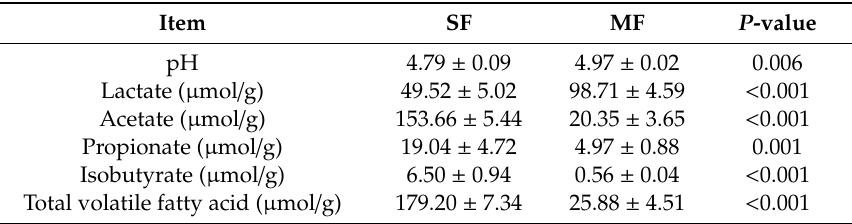
Table 1. The pH, lactate and volatile fatty acid concentration in fermented feed